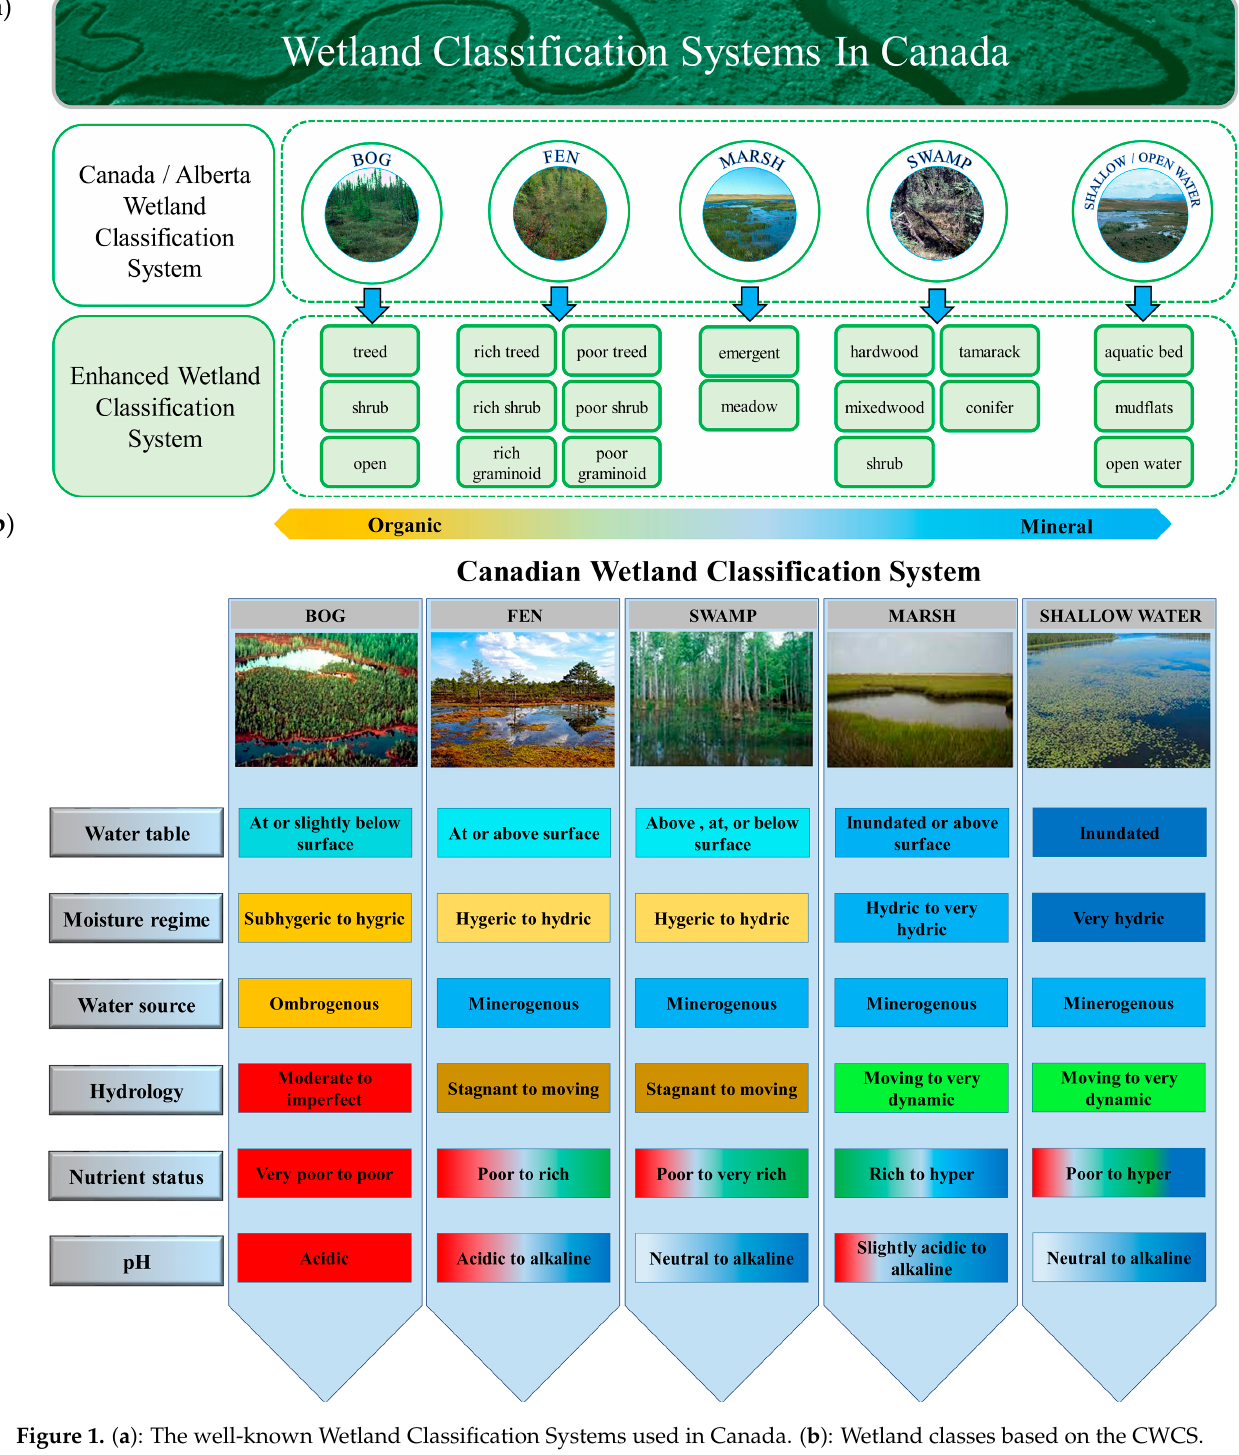
sphagnum or sedge-dominated peat in bogs and fens. The water table fluctuates in swamps, and they are not permanently saturated or inundated like bogs and fens; thus, the soil layer can be well-aerated [80]. Marsh is a type of mineral wetland class that experiences a high temporally periodical (seasonal/annual) rate of inundation. The hydrology inputs are from numerous